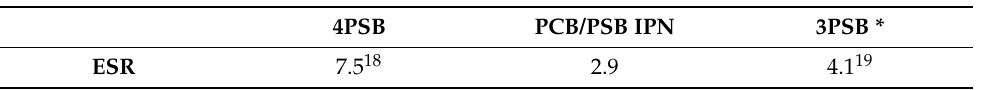
Table 2. ESR of PCB/PSB IPN hydrogel in distilled water. For sake of comparison the data for single PSB and PCB networks are also provided [18,19].